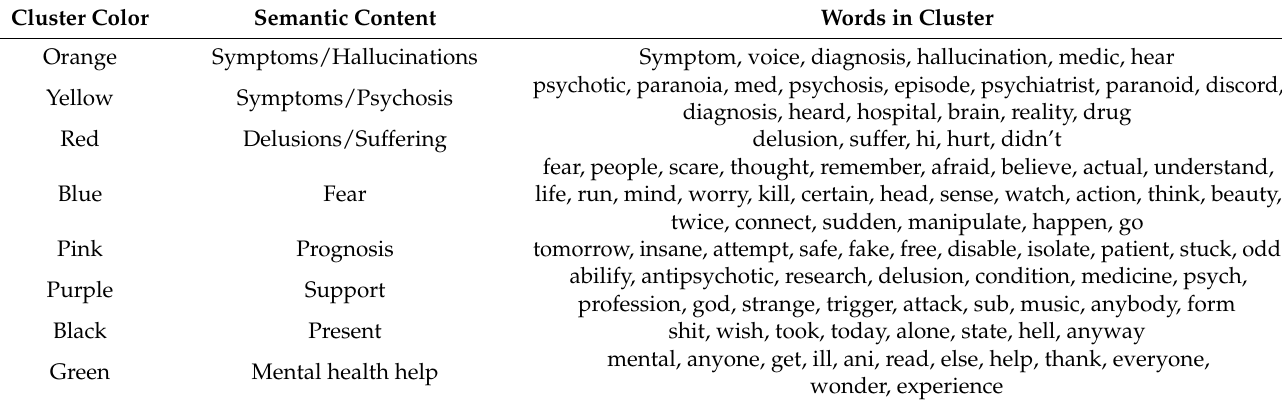
Table 6. Lists of the most predictive words for